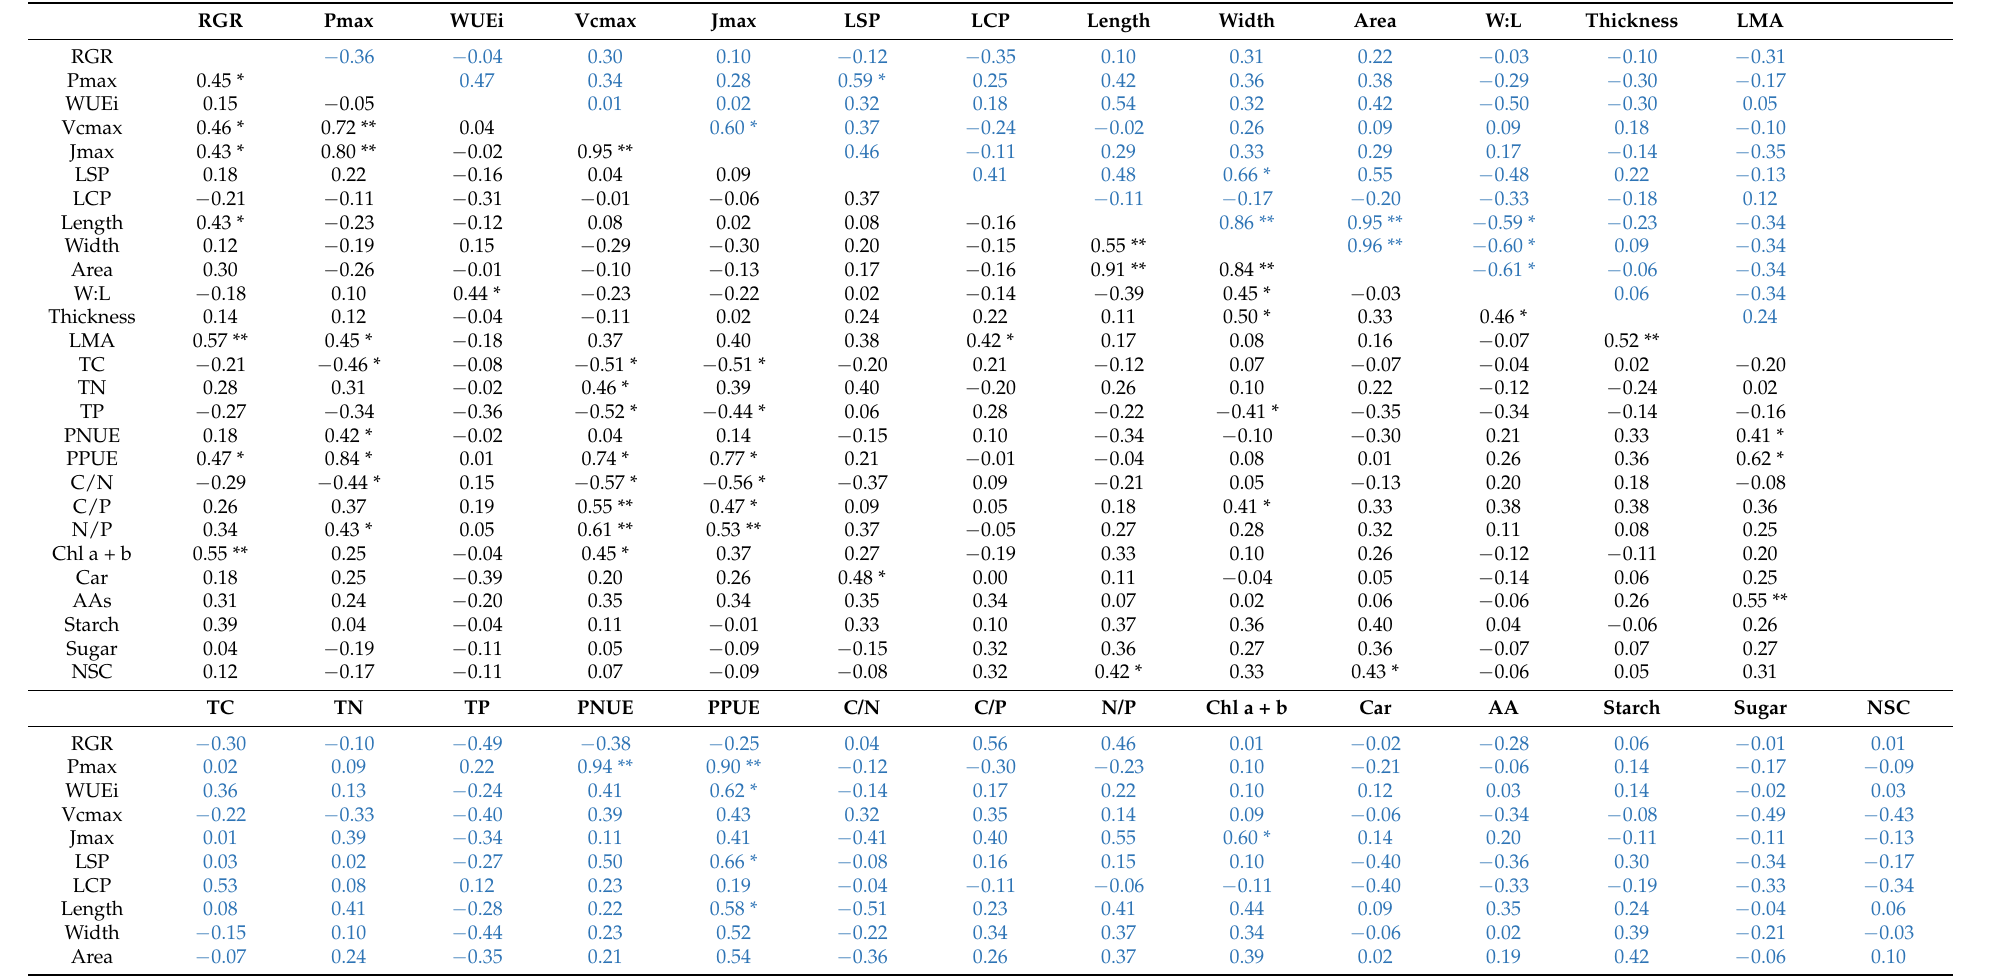
Table A1. Pearson correlation coefficients among leaf functional traits and growth rate for S. superba seedlings under field and pot experimental